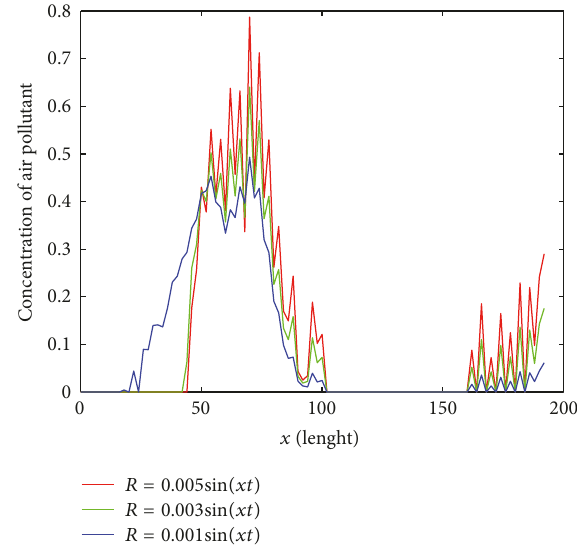
Figure 14: Compare the concentration of air pollutant where 𝑅 = 0.